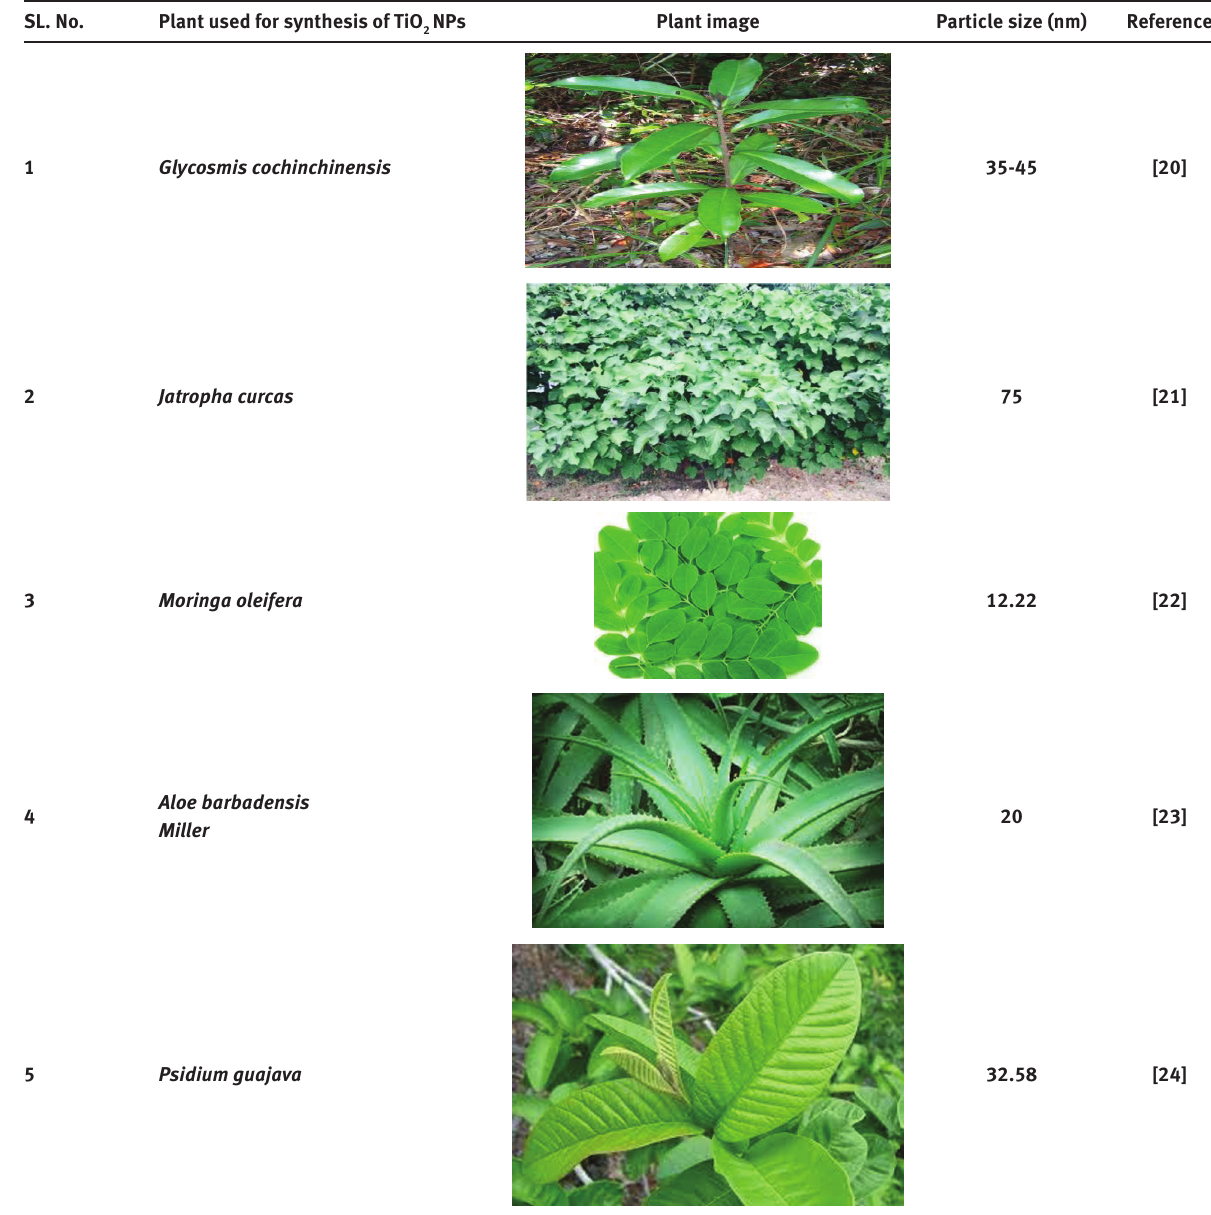
Table 1: Nanoparticle synthesize from different plant extract. SL.